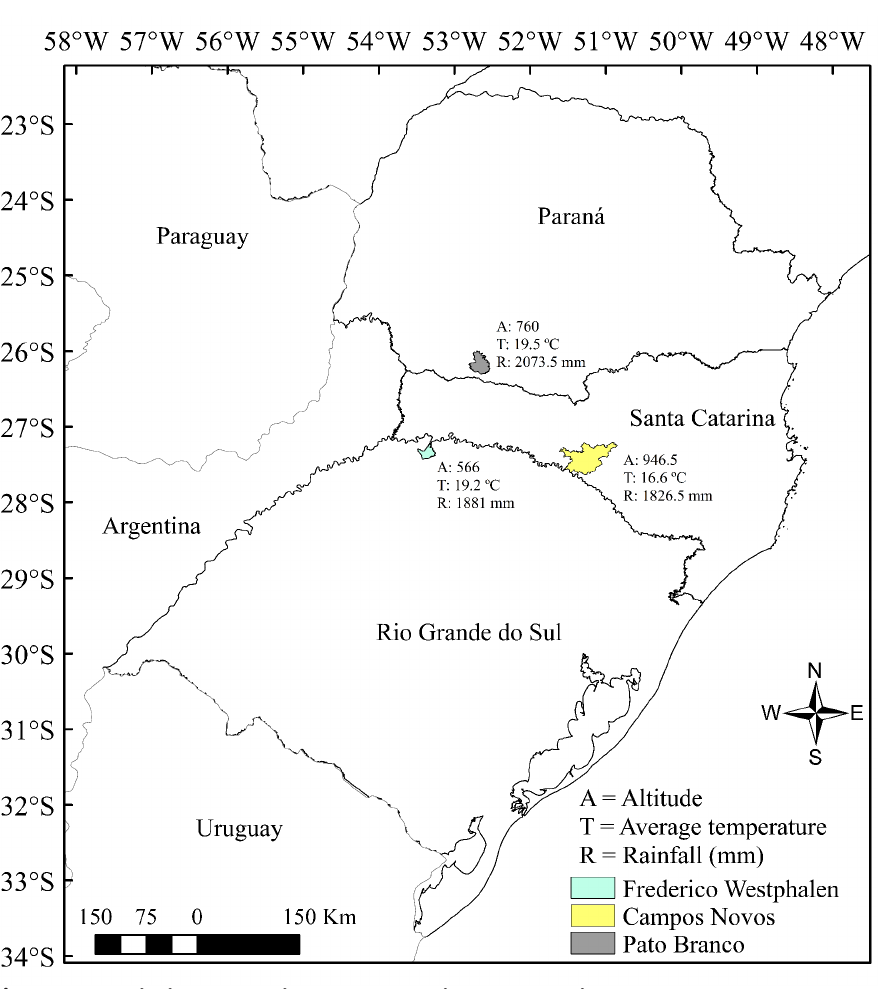
Figure 1. Description of the sites when the trials were carried